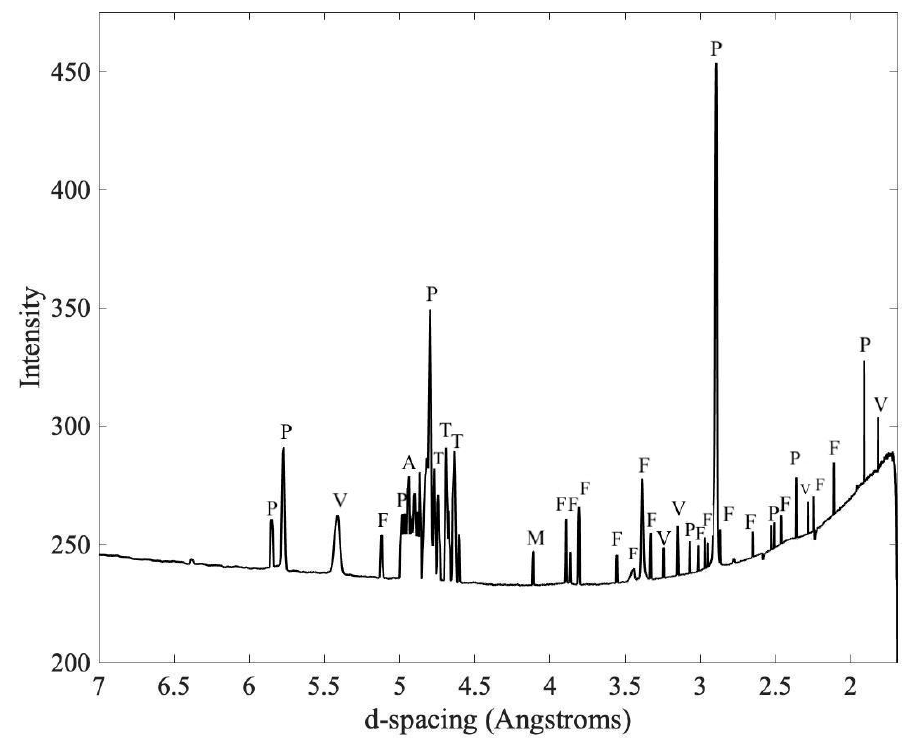
Figure 10. Microdiffraction powder pattern CS BayShore3: Pentlandite (P), forsterite (F), violarite (V), troilite (T), alunite (A), and melanterite (M). The predominant presence of pentlandite and forsterite peaks are indicative of extraterrestrial origin [12–15].